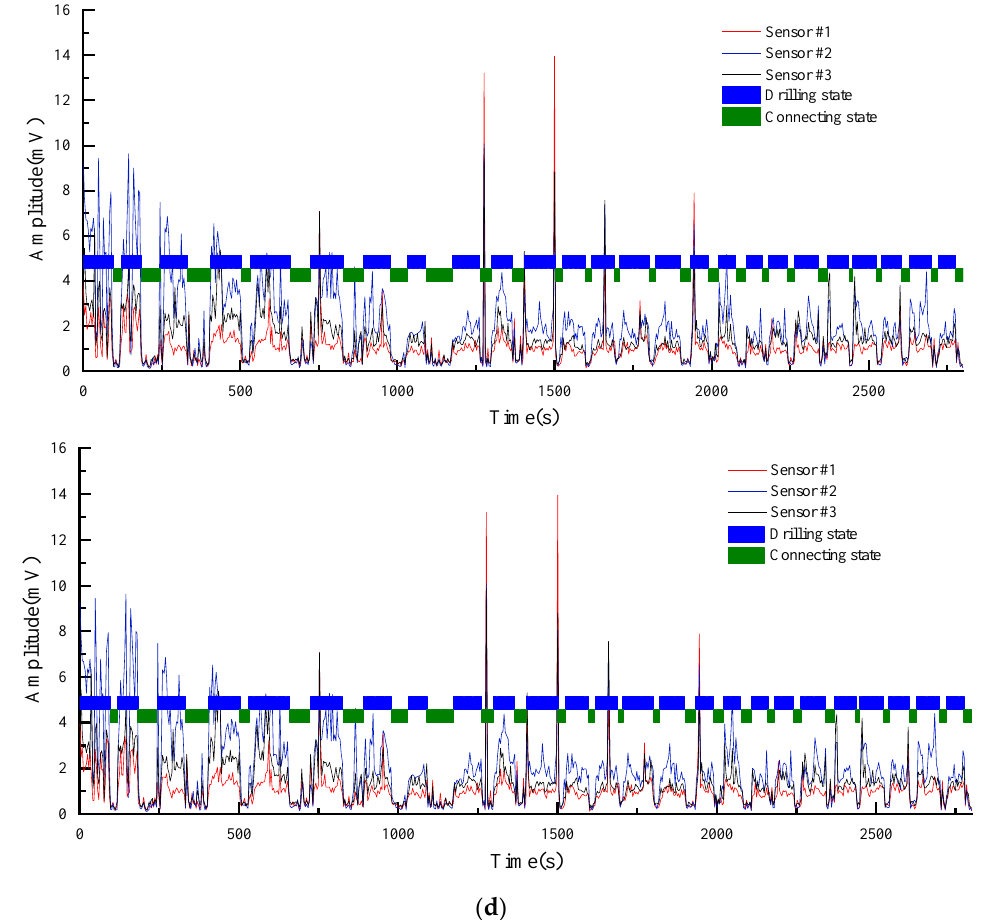
Figure 9. Test#1 drilling state final identification results. ( a ) Drilling state final identification result and vibration signal of Sensor #1. ( b ) Drilling state final identification result and vibration signal of Sensor #2. ( c ) Drilling state final identification result and vibration signal of Sensor #3. ( d ) Drilling state final identification result and vibration signal of all sensors.